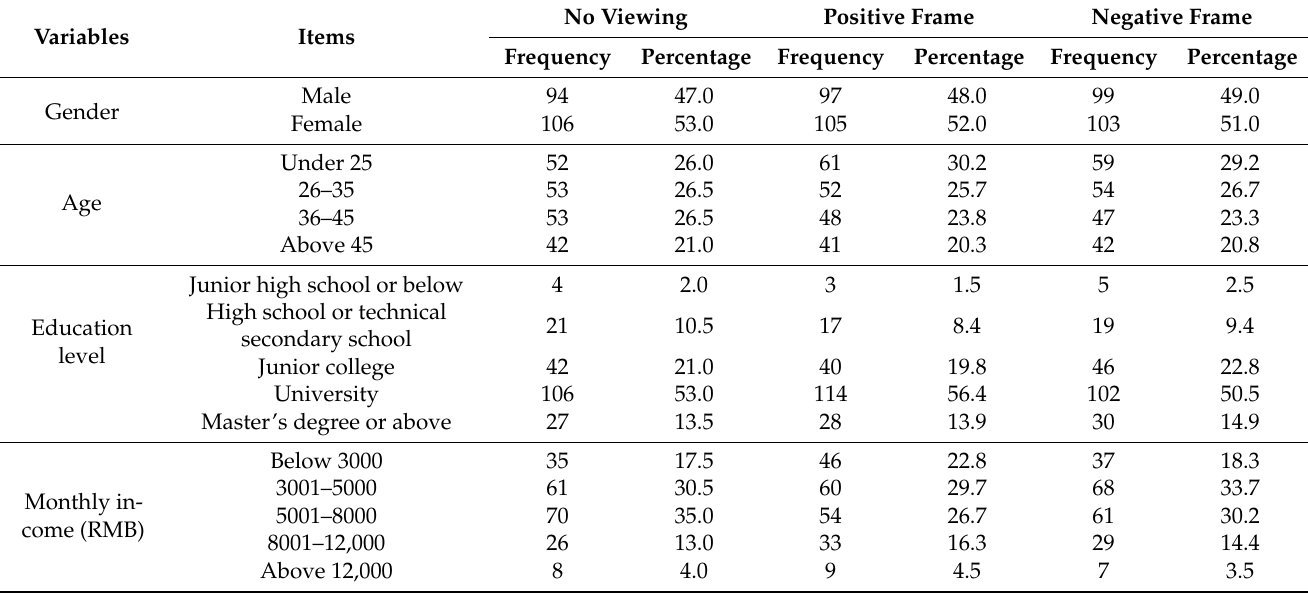
Table 1. Descriptive statistics of demographic